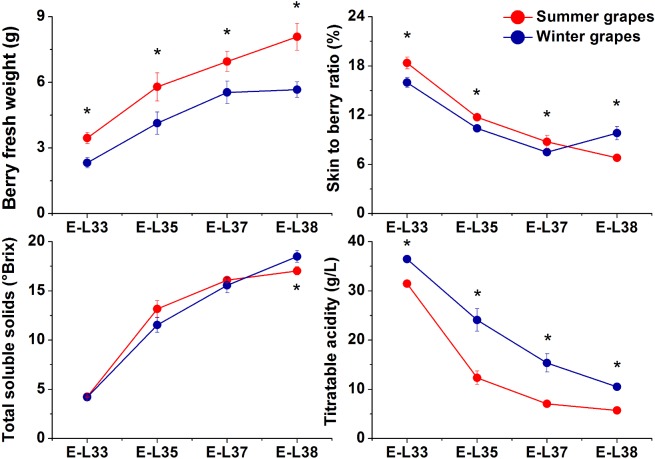
Evolution of berry fresh weight (A), the skin-to-berry ratio (B), TSS (C) and TA (D) in grapes grown under a two-crop-a-year cultivation system in 2016. The four points refer to stages E-L 33, 35, 37 and 38, respectively. The asterisk indicates significant differences between the samples from the same stage.